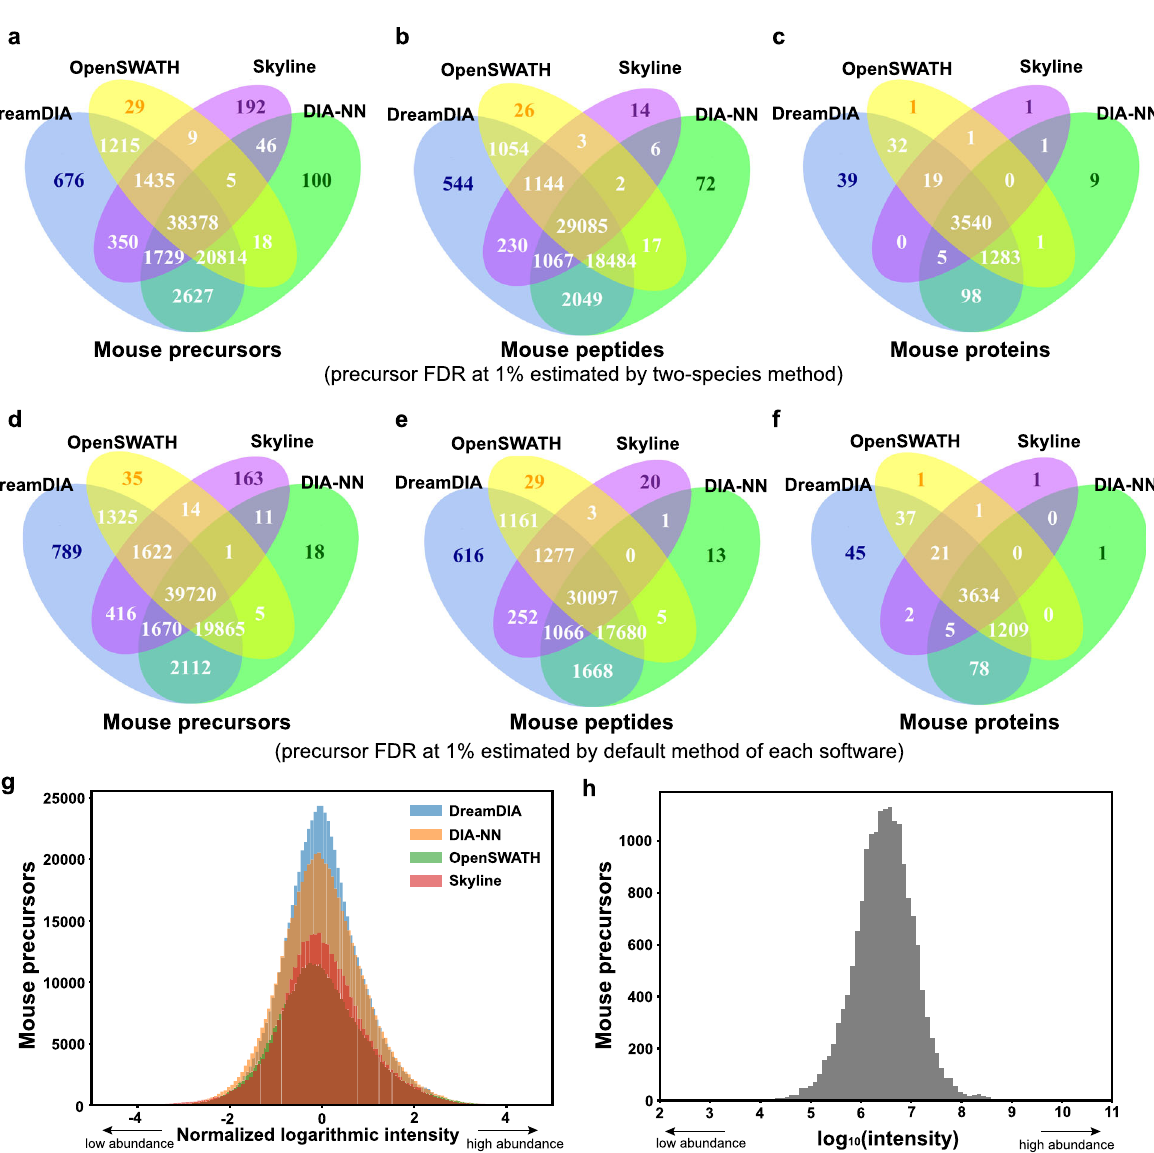
Fig. 3 Identi fi cation results evaluation of DreamDIA on the mouse cerebellum dataset. a – f Identi fi cation consistency of mouse precursors, peptides, and proteins at 1% precursor FDR using two-species library method and decoy-based default FDR method. Precursors identi fi ed at least once for each software tool in all 10 runs on the MCB dataset were considered. g Logarithmic intensity distributions of the mouse precursors identi fi ed at 1% precursor FDR using two-species library method. All the precursor identi fi cation records in all 10 runs for each software tool were considered. To make the distributions comparable, the logarithmic intensities were z-normalized by subtracting the mean intensity and then divided by the standard deviation. h Log 10 -intensities of the precursors uniquely identi fi ed by DreamDIA in all the biologically independent 10 runs on the MCB